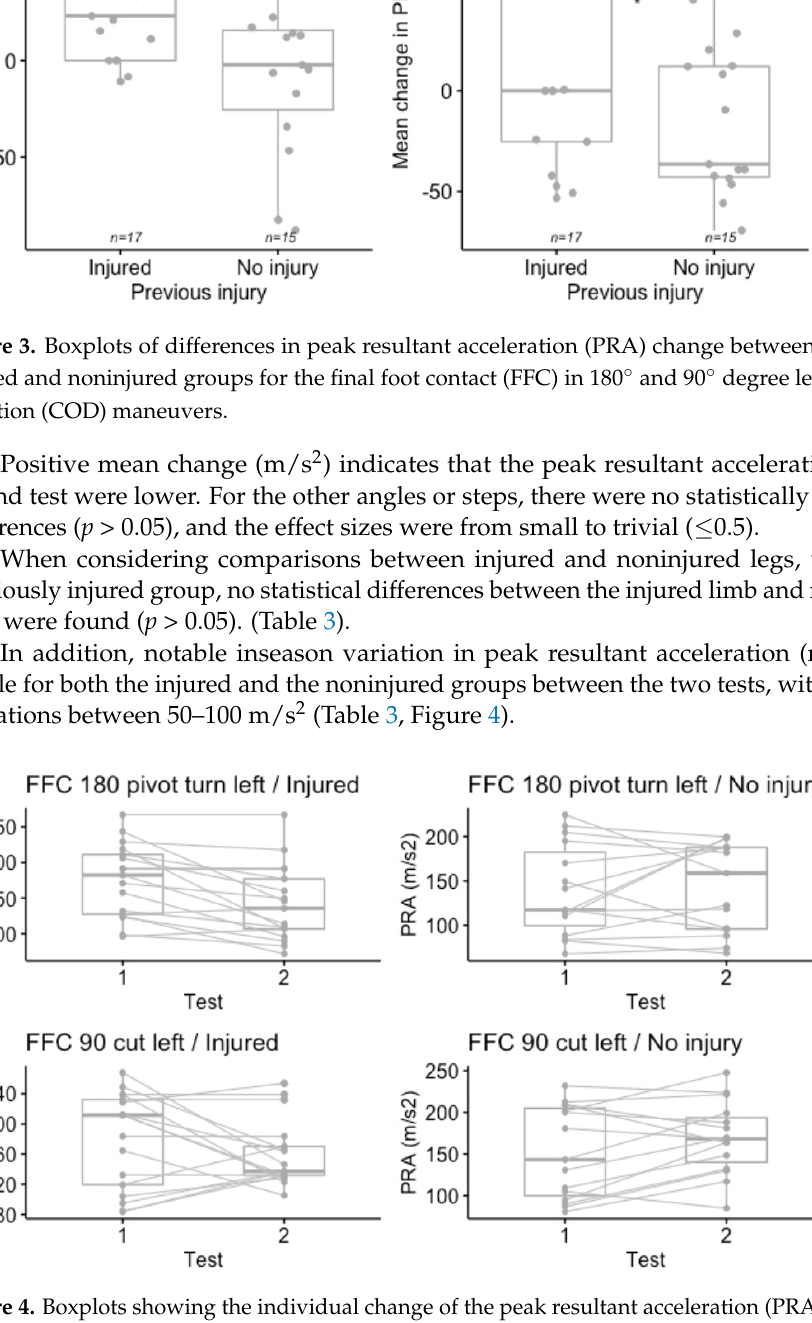
for the final foot contact (FFC) in 180° pivot turns and 90° cuts between Test 1 and Test 2. the final foot contact (FFC) in 180 ◦ pivot turns and 90 ◦ cuts between Test 1 and Test